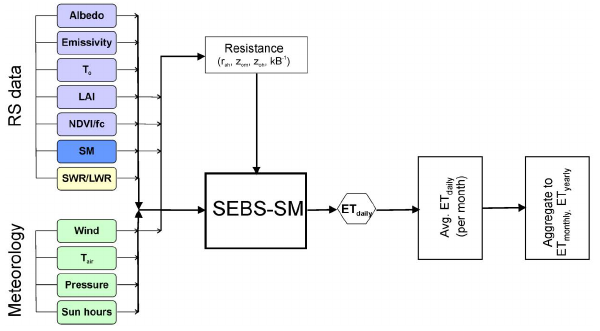
Fig. 4. Input data for SEBS-SM and flowchart for obtaining yearly ET (Adapted from Gokmen et al., 2013). In the figure, T 0 : surface temperature, T air : air temperature at reference height, LAI: leaf area index, NDVI/fc: normalized difference vegetation index/fraction of vegetation cover, SM: soil moisture, SWR/LWR: short-wave in- coming radiation/long-wave incoming radiation, r ah : aerodynamic resistance, z 0h : roughness height for heat, z 0m : roughness height for momentum, kB − 1 : dimensionless excess resistance